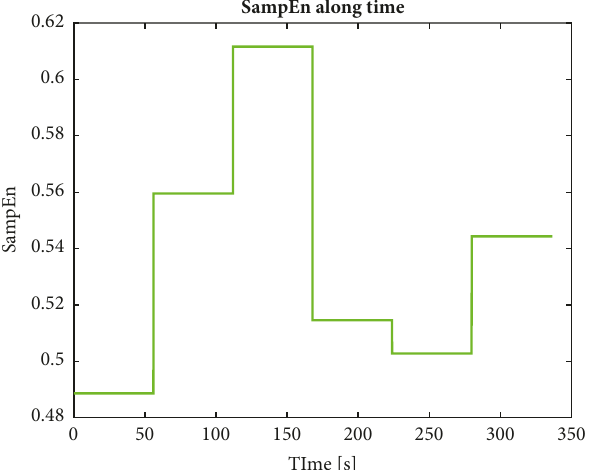
Figure 22: SampEn estimates of the IMFs or modes of interestalong time.